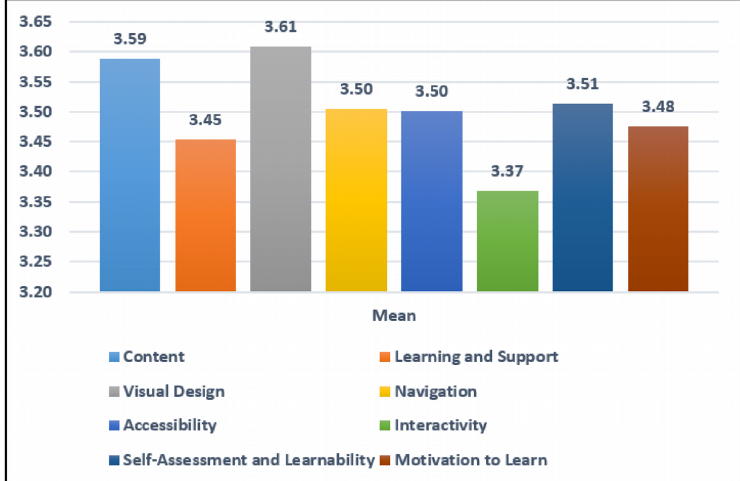
Figure 2 . Mean of the eight criteria regarding the usability of the e- learning courses at Ajman